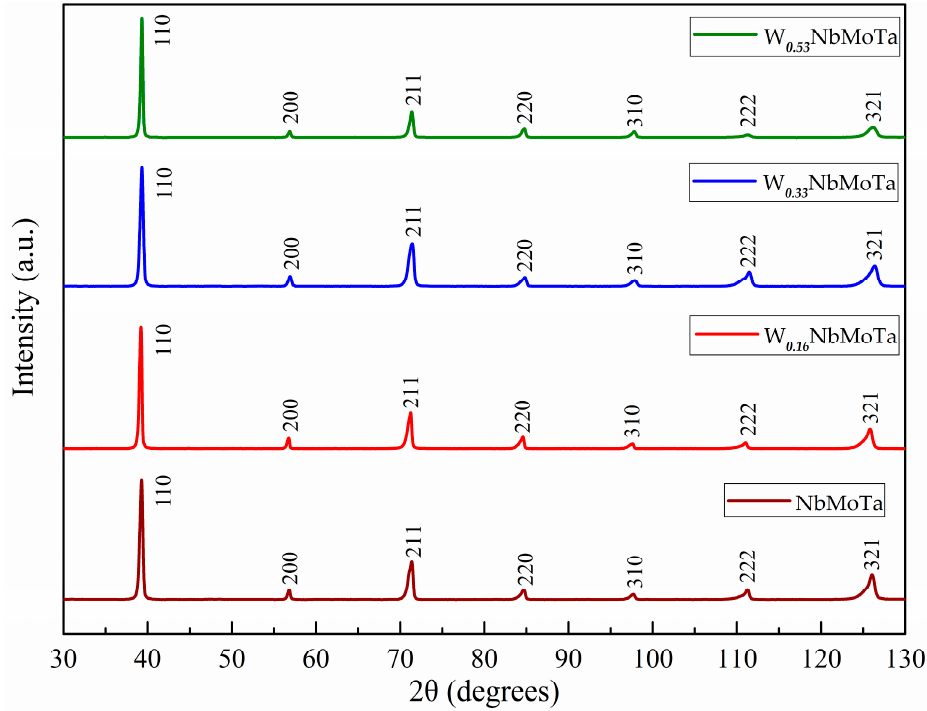
Figure 4. X-ray diffraction (XRD) patterns of the W x NbMoTa alloys.